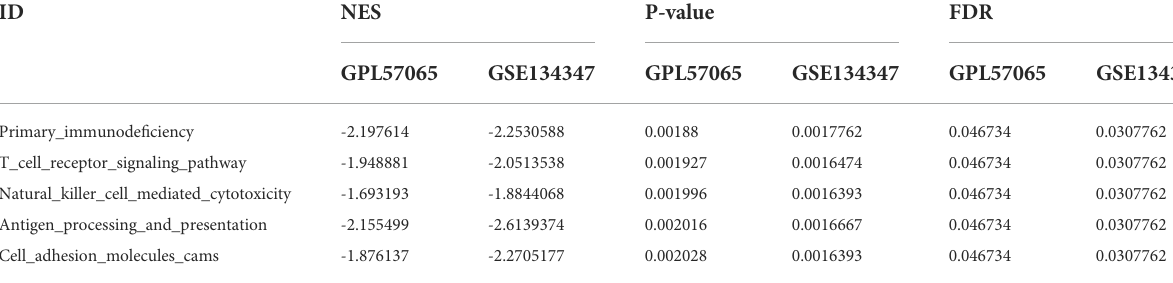
TABLE 3 The signi fi cant enriched KEGG pathways from GSEA results ( p < 0.01, FDR < 0.25). ID